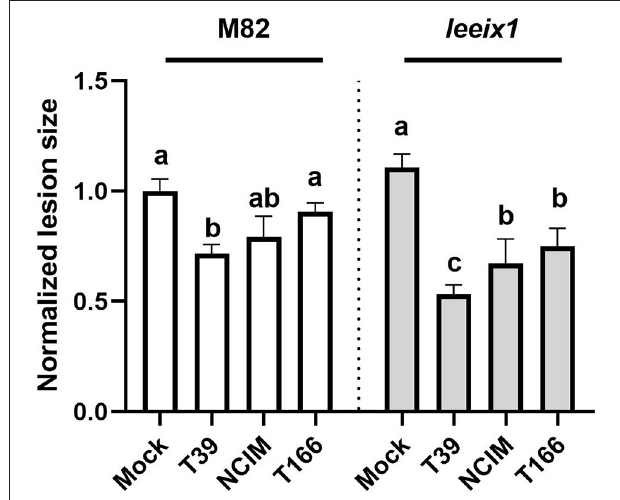
FIGURE 5 | leeix1 mutants have improved disease resistance in response to additional Trichoderma strains. WT M82 and leeix1 plants were challenged with B. cinerea (10 6 conidia /mL). Relative disease area was calculated as the lesion area measured 5 days after inoculation in each genotype treated with indicated Trichoderma strains as compared to mock-treated controls. Average ± SEM of 4 independent replicates is shown, N = 16, p < 0.0077 in a two-tailed t -test.